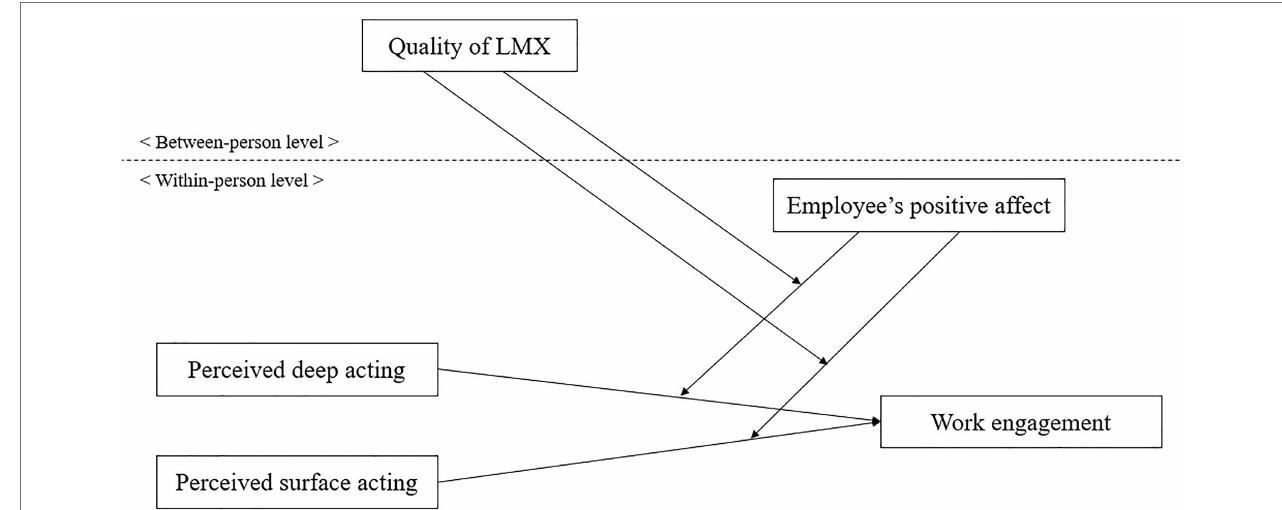
FIGURE 1 | Proposed research